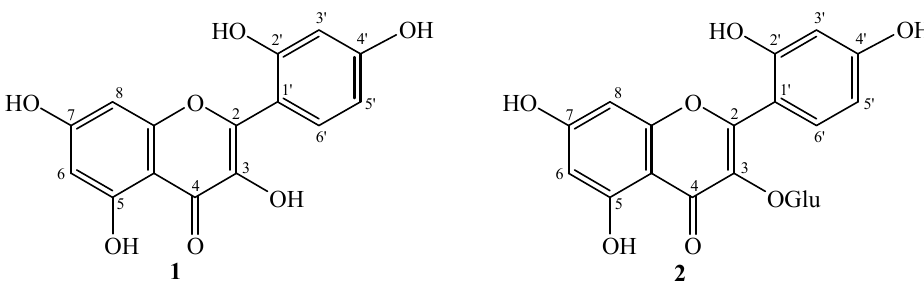
Figure 1. Structures of compound 1 and 2